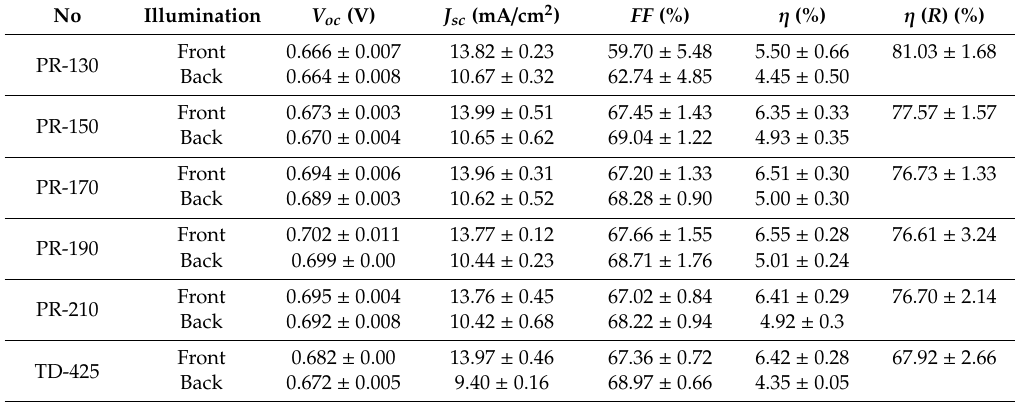
Figure 5. ( a ) Transmittance spectra of the Pt counter electrodes, ( b ) J–V characteristic curves of the dye-sensitized solar cells (DSSCs) (5 µ m-thick TiO 2 ) under one sun front illumination, and ( c ) their incident photon-to-current conversion e ffi ciency (IPCE) spectra. Table 3. Photovoltaic parameters of DSSCs (5 µ m-thick TiO 2 ) with di ff erent Pt counter electrodes a